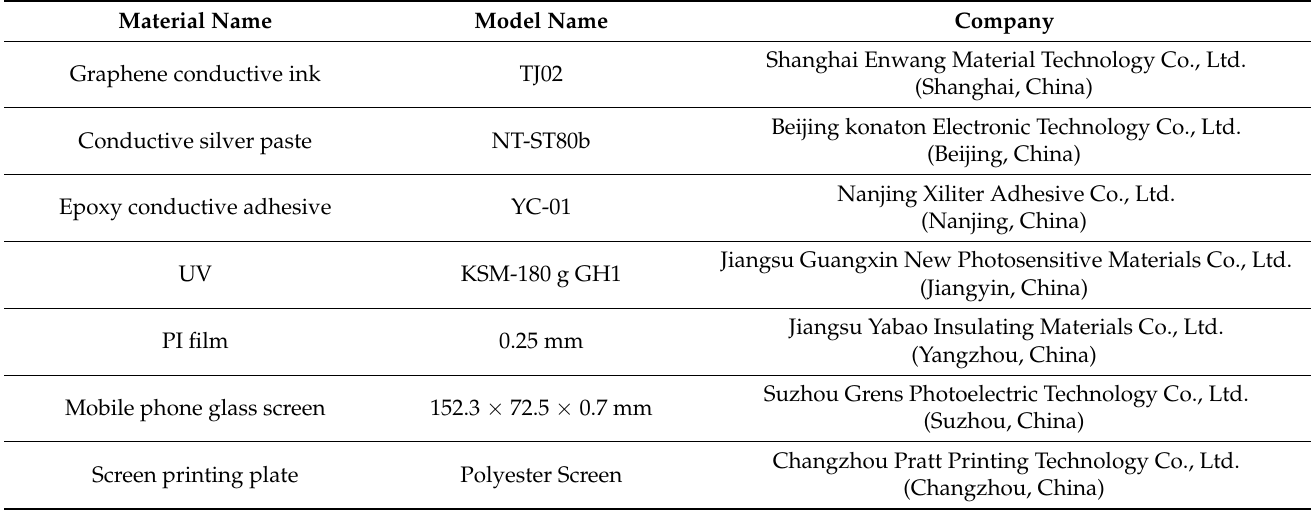
Table 1. Materials and models, and the companies that made them, used in the experiments.